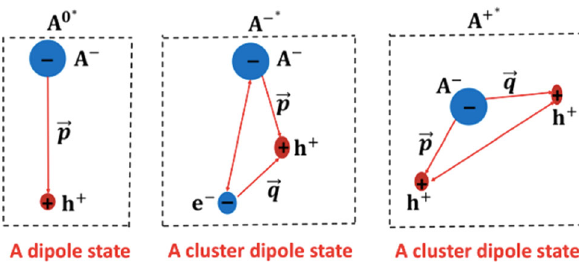
Fig. 1 Shownaretheprocessesinvolvedintheformationoftheexcited dipole states and the cluster dipole states in a p-type Ge detector oper- ated at low temperatures, where p and q are the corresponding dipole moments